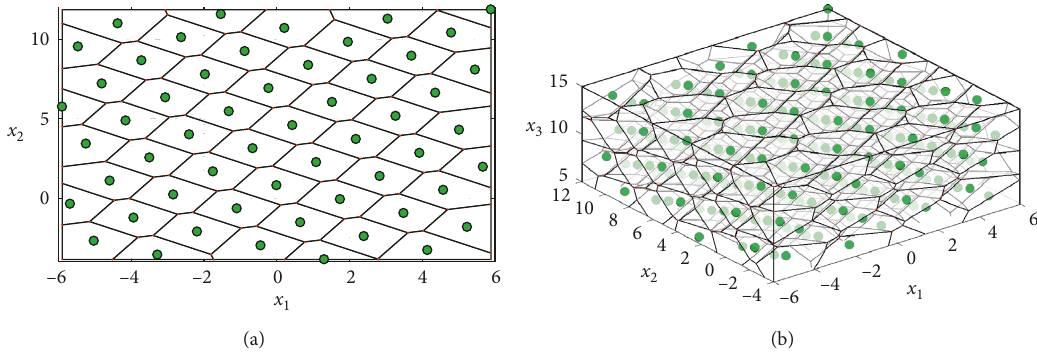
Figure 2: GP points (green “o” marker) and Voronoi regions (polyhedral). (a) 2 variables; (b) 3